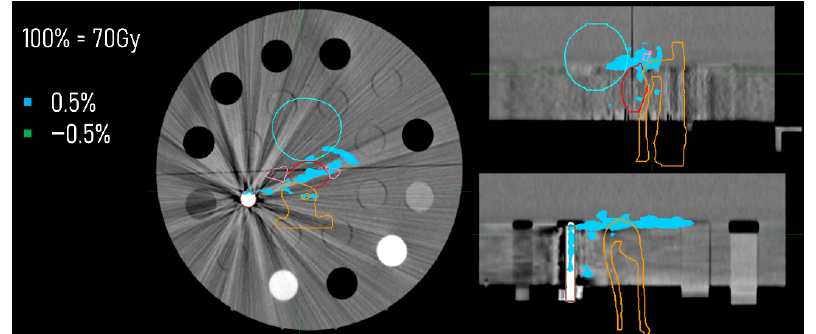
Figure 9. The absolute maximum differences in dose, expressed as the percentage of the dose to the prostate (100% = 70 Gy), between the dose distributions calculated on the DD reconstructions of the CT scans of the Cheese phantom with the stainless-steel insert acquired at 100 kVp and 140 kVp, respectively. Blue shading corresponds to maximum differences of 0.5%. The analysis was conducted with MIM Maestro ® and differences were reported on the DD reconstruction of the Cheese phantom acquired with the stainless-steel insert at 100 kVp (axial section on the left, sagittal section at the upper right corner, and coronal section at the lower right